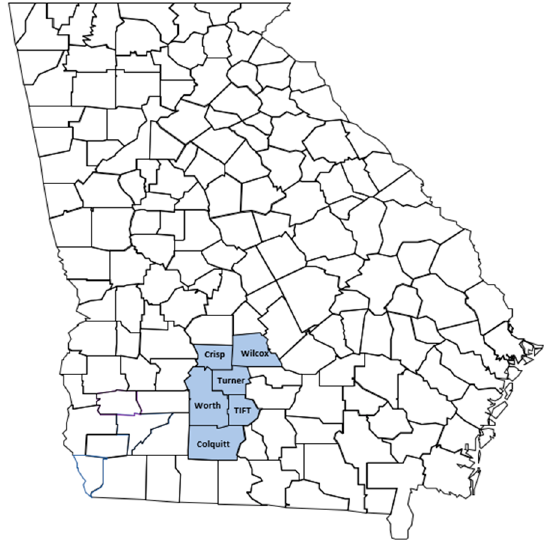
Figure 1. Map of Georgia showing counties from which melon samples were collected during spring 2021 survey.